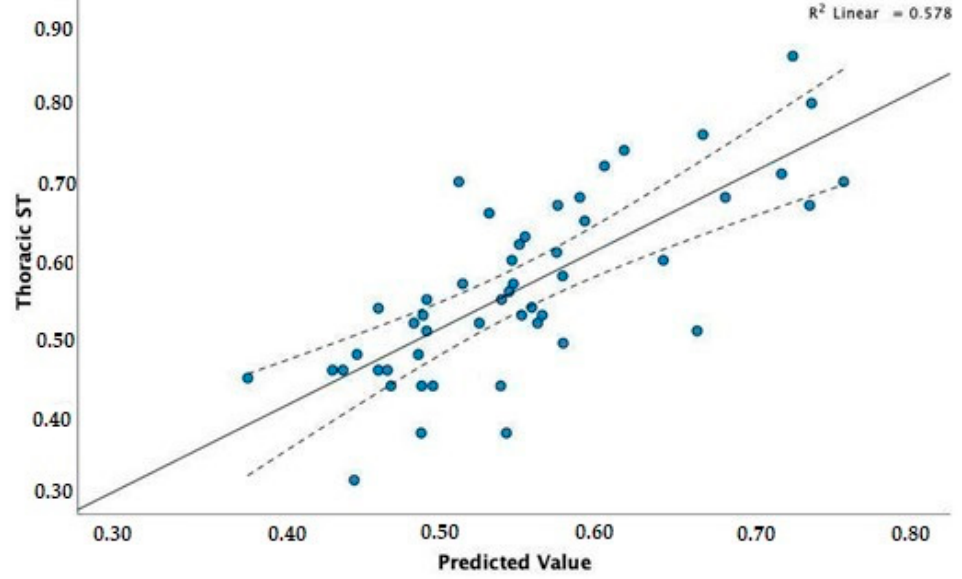
Figure 3. Correlation scatterplot of thoracic ST for the observed values and those predicted by the model.